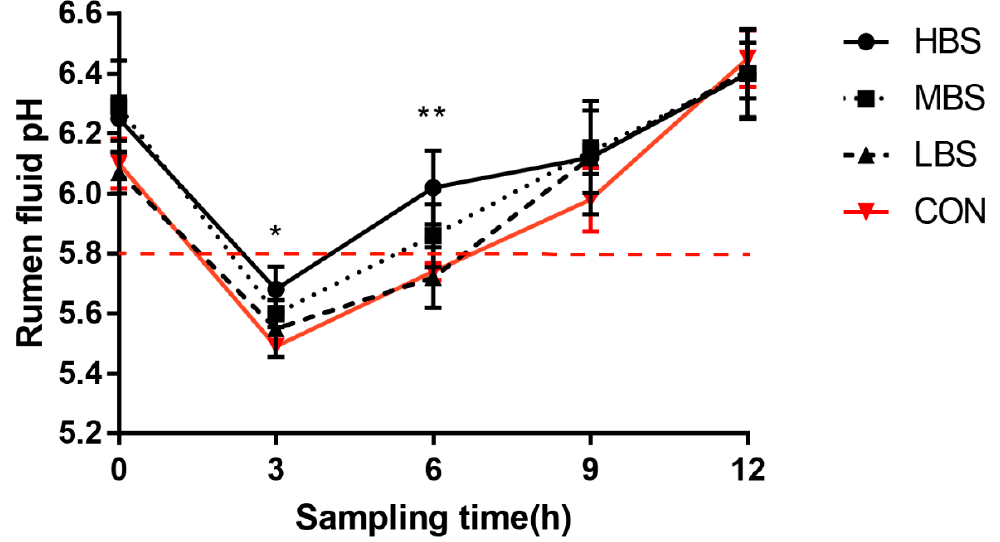
Figure 1. Mean ruminal pH values with different levels of β -sitosterol (BSS) supplementation. CON: basal diet without supplement; LBS: basal diet low supplemented with 0.25 g of BSS/kg of dry matter intake (DMI); MBS: basal diet medium supplemented with 0.5 g of BSS/kg of DMI; HBS: basal diet high supplemented with 1 g of BSS/kg of DMI. SEM, standard error of the mean. Data were expressed as mean ± SE. * indicates differences between dietary treatments at p < 0.05.; ** indicates differences between dietary treatments at p < 0.01.